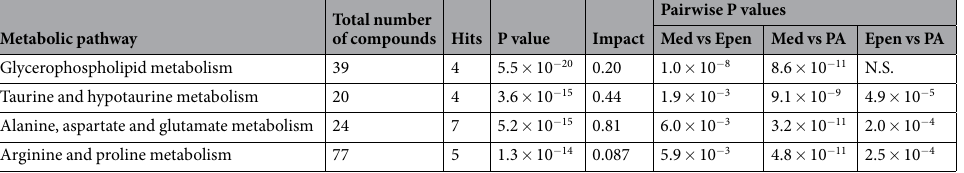
Table 3. The top 4 most significantly different pathways between the three most common cerebellar tumors. Glycerophospholipid metabolism is enriched in medulloblastoma compared to the other two tumor types. The alanine, aspartate and glutamate metabolism pathway has the highest topological metric, and it is likely that this pathway is strongly associated with tumor